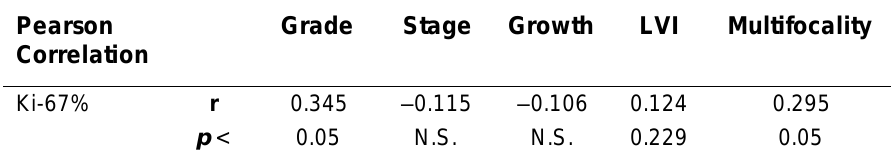
Ki-67 Index in Relation to Grade, Stage, Growth, LVI, and Multifocality of BEN Tumor